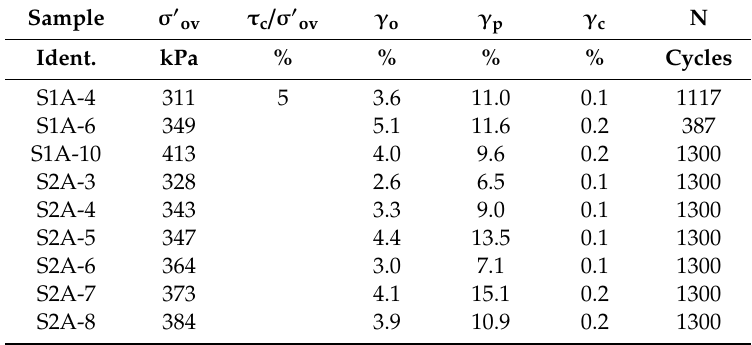
Table 9. Results of cyclic simple shear test with τ o / σ (cid:48) ov = 25%.